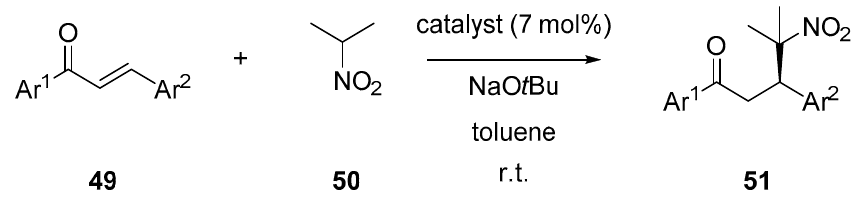
Table 1. Effect of crown ethers in the Michael addition of 2-nitropropane ( 50 ) to chalcones ( 49 ). Entry Ar 1 Ar 2